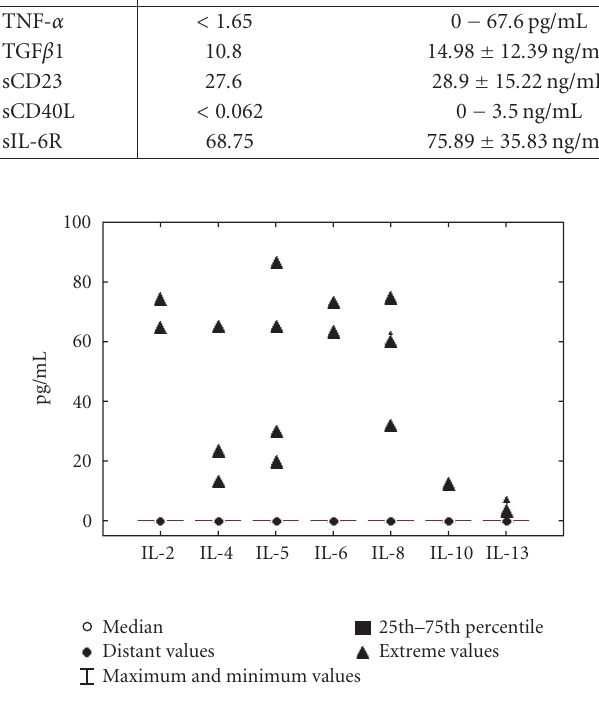
Figure 1: Plasma concentration of measured interleukins. The graph (box-and-whiskers plot) shows the median and extreme val- ues of measured concentrations of interleukins IL-2, IL-4, IL-5, IL- 6, IL-8, IL-10, and IL-13. There was no correlation among measured extreme values of di ff erent interleukins. All median values of in- terleukins were 0. For the detection limits of particular assays,